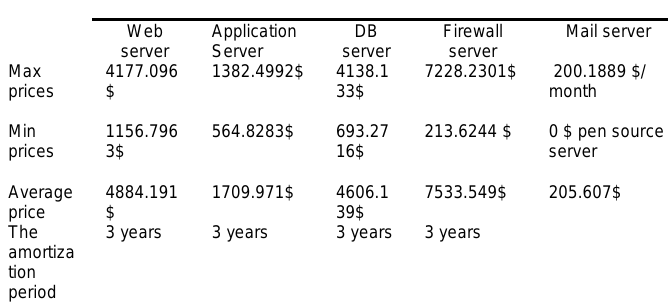
Table 4: The architectural components prices and the amortization period for an e-learning system case